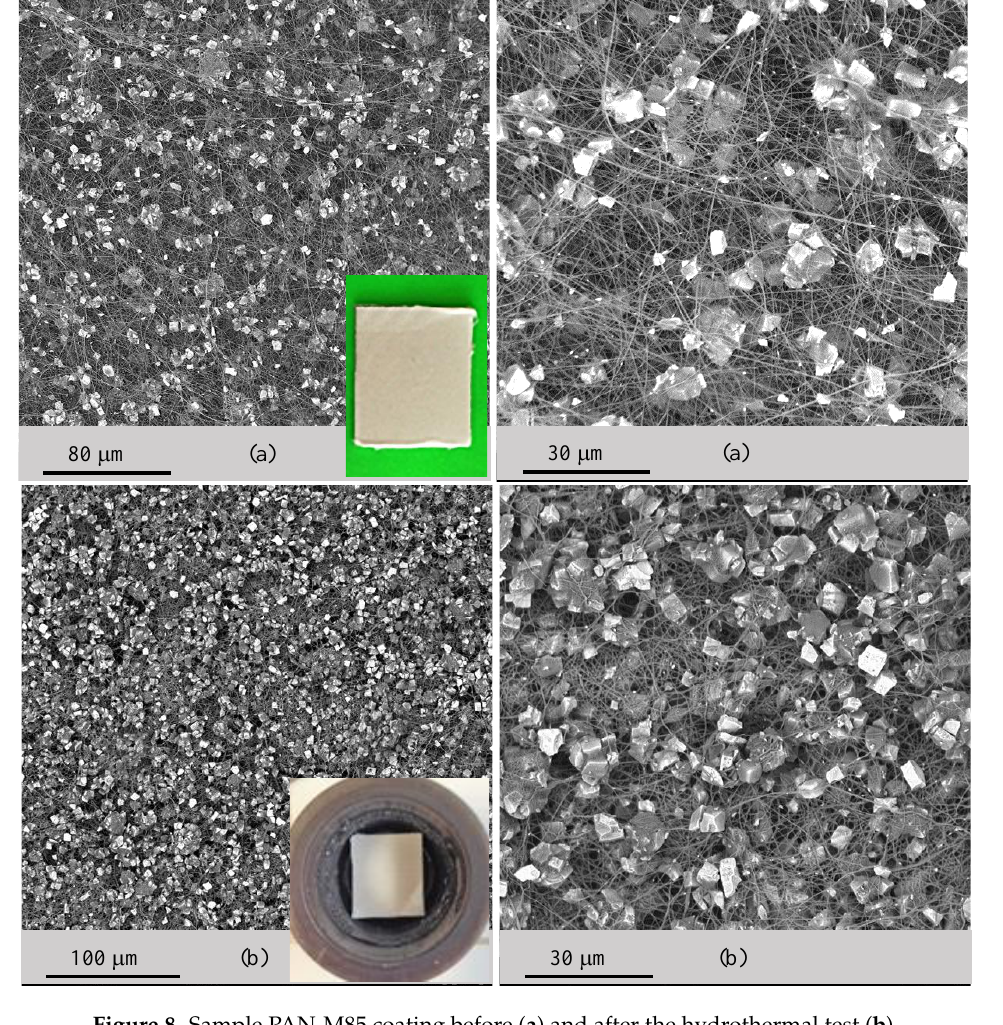
Figure 8. Sample PAN-M85 coating before ( a ) and after the hydrothermal test ( b ).